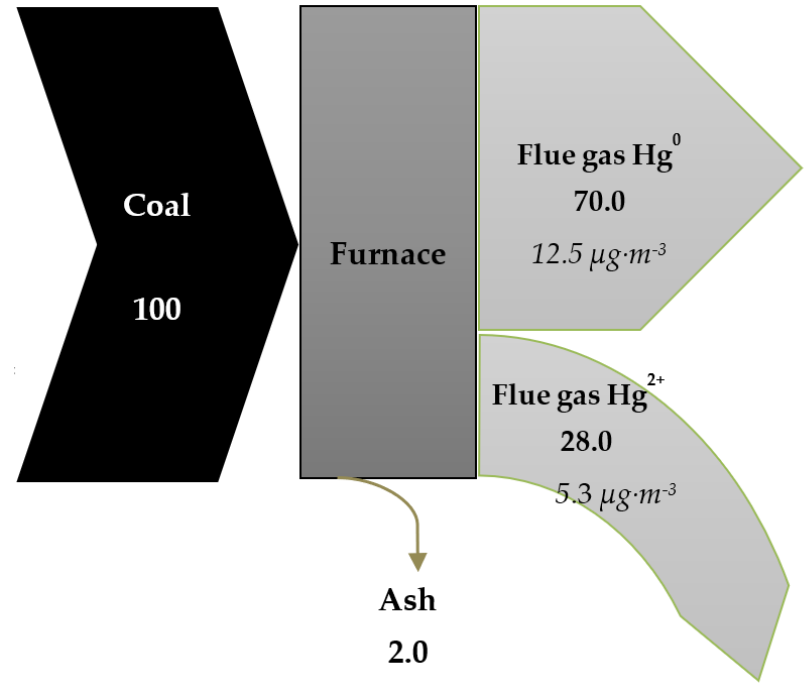
Figure 4. Sankey diagrams of mercury distribution (%).